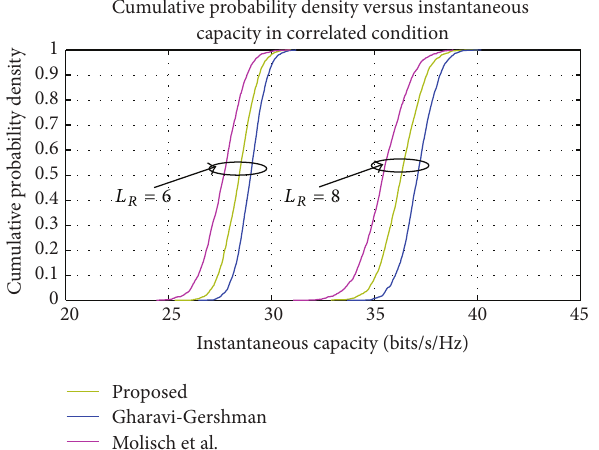
Figure 8: Plots showing the variation of cumulative probability density versus instantaneous capacity for 𝑀 𝑇 = 16 , 𝑀 𝑅 = 16 and = 6 and 8 under correlated. 𝐿 𝑅